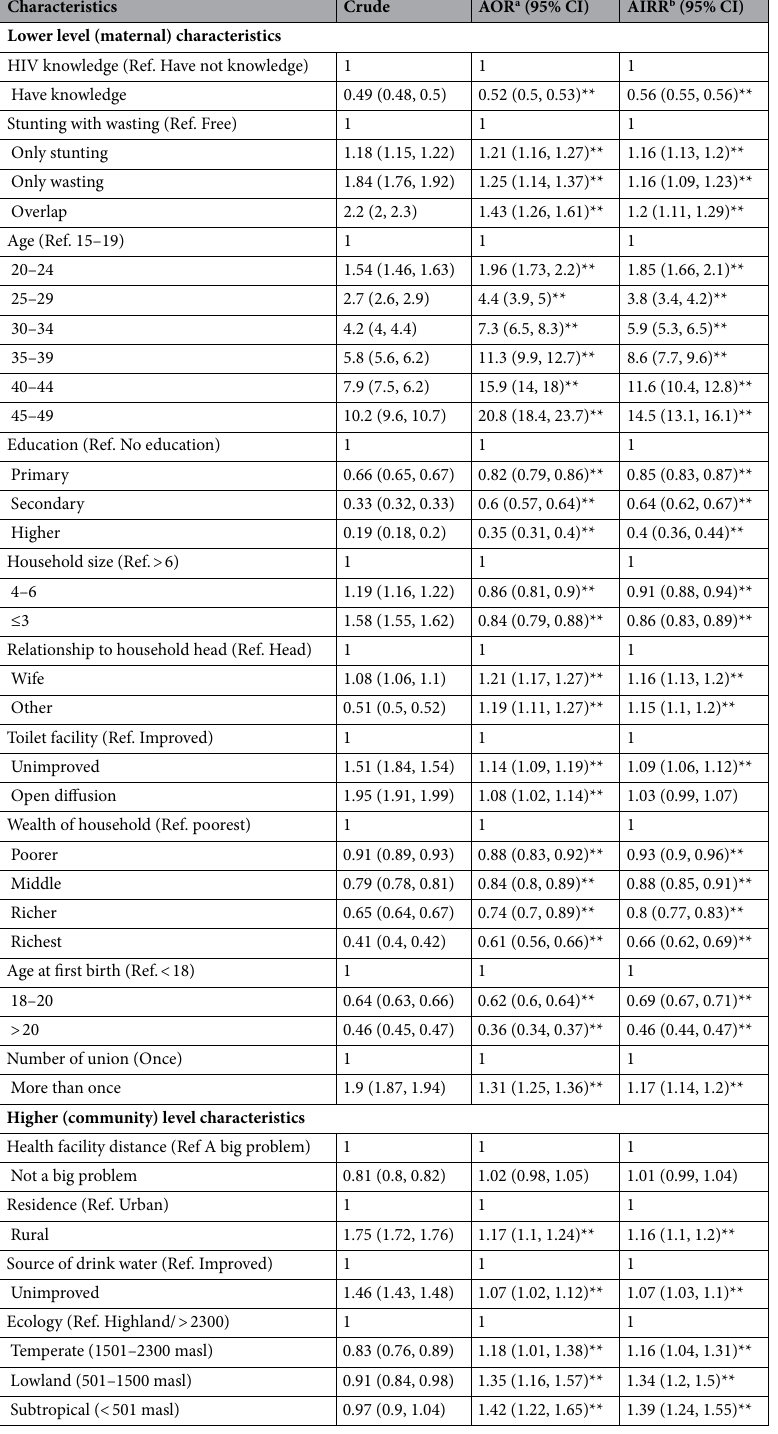
Table 3. Multilevel regression associated characteristics with child death and mothers suffering child death. a AOR: adjusted odds ratio for mixed effect logistic regression. b AIRR: adjusted incidence rate ratio for mixed effect negative binomial